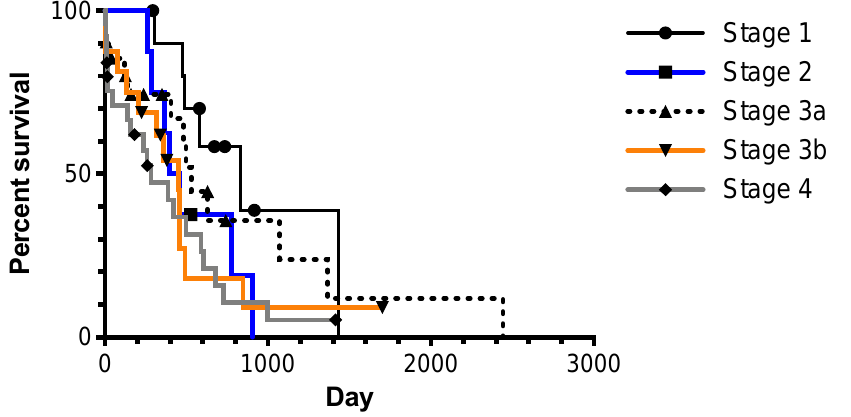
Figure 1. Kaplan–Meier plot of AGASAC cases grouped by Polton stage. Log-rank p = 0.1056. Symbols indicate censored cases.